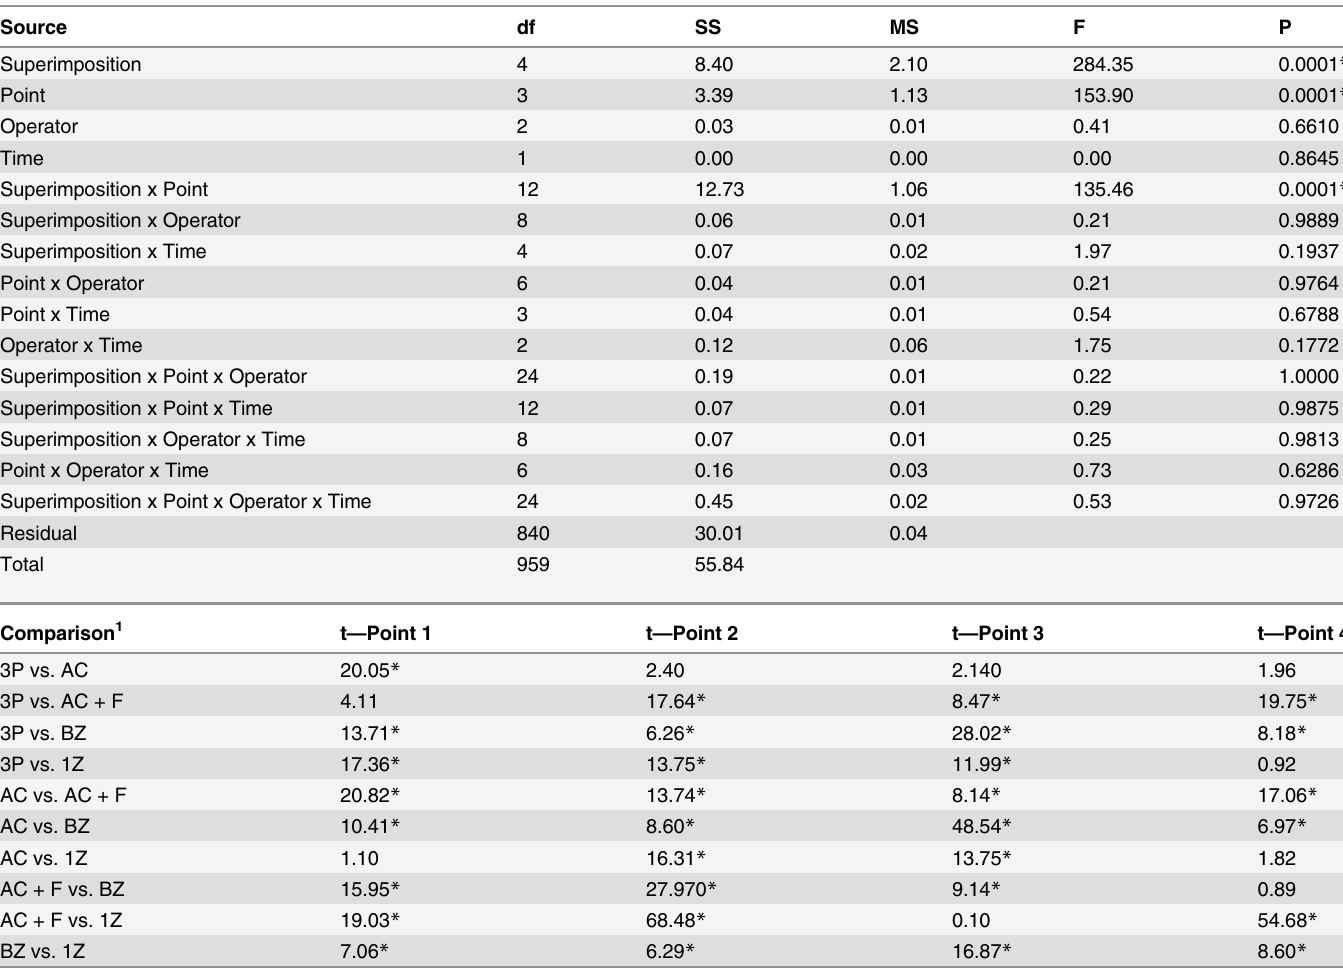
Table 3. Non parametric MANOVA on precision measurements (distances between